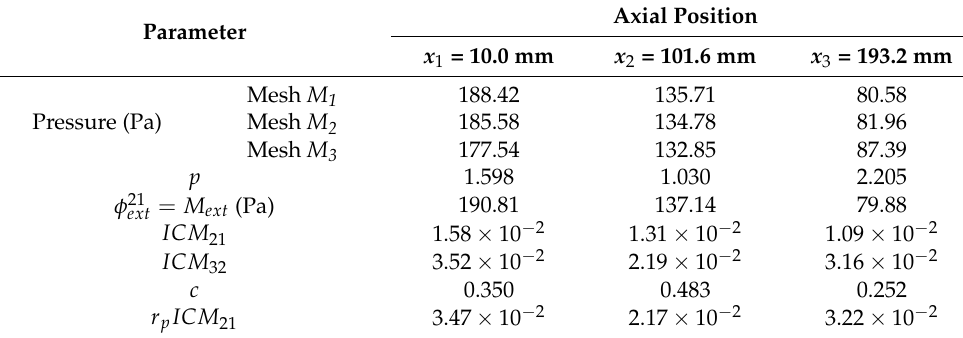
Figure 8. Axial positions of lines for collecting pressure data. Table 8. Parameters obtained from the study of the Grid Convergence Index for pressure as response variable ( y = 0.159